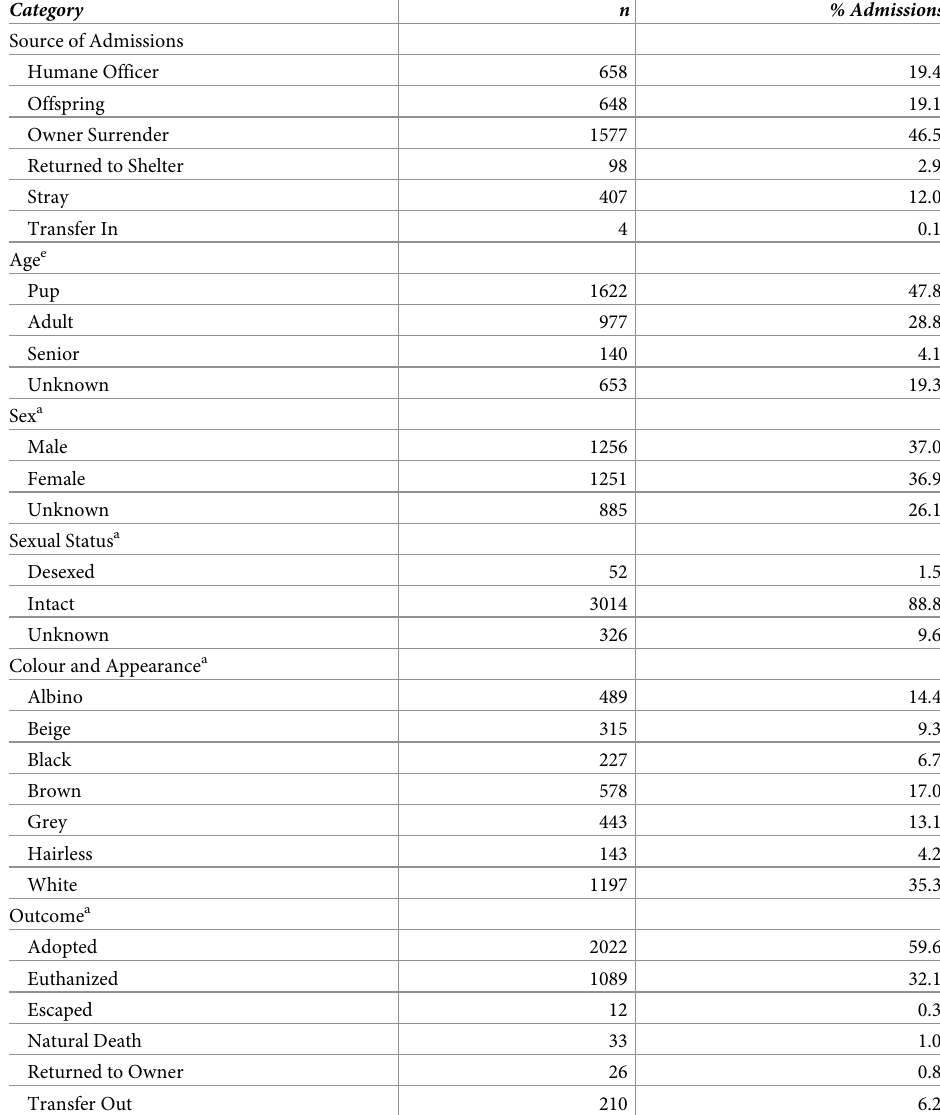
Table 2. Breakdown of admission data and physical characteristics of rats upon intake (N =